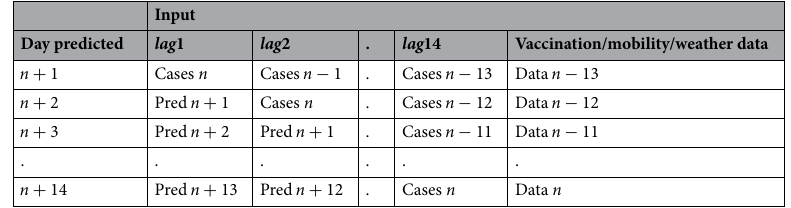
Table 2. Input for predicting data for days n + 1 to n + 14 using ML models. Note the feedback process taking place in the lags column.